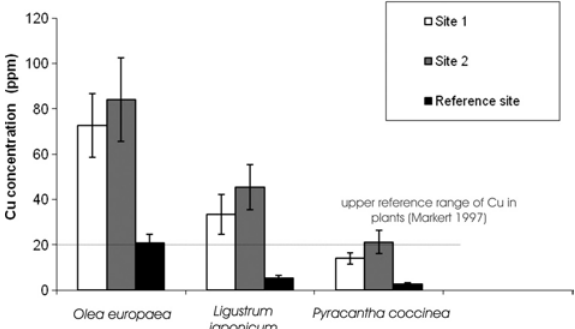
Fig. 4. Copper concentrations (ppm dry wt) in leaves of Olea europaea , Ligustrum japonicum, and Pyracantha coccinea from different studied sites (site 1: industry; site 2: traffic; reference site: botanical garden)